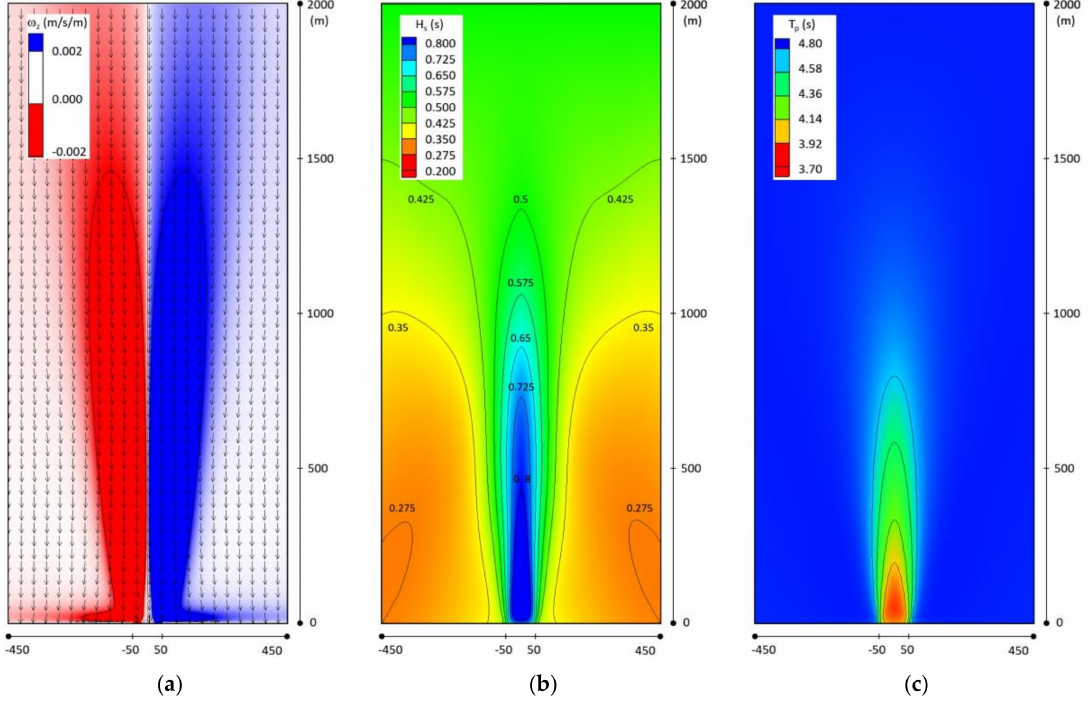
Figure 6. Variations obtained in the simulation T5M of the following parameters: ( a ) the z-directed component of the current vorticity, defined as the curl of the flow velocity vector, with superimposed arrows representing the mean direction of the waves; ( b ) the significant wave height H s ; ( c ) the relative peak period T p